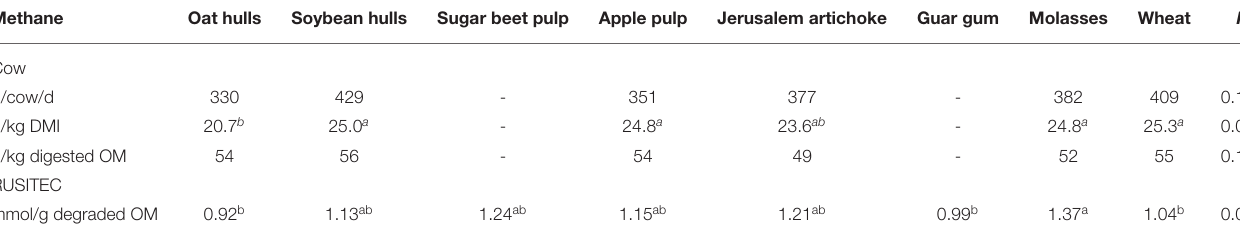
TABLE 3 | Enteric methane emissions from cows and RUSITEC fed different diets (53, 123).